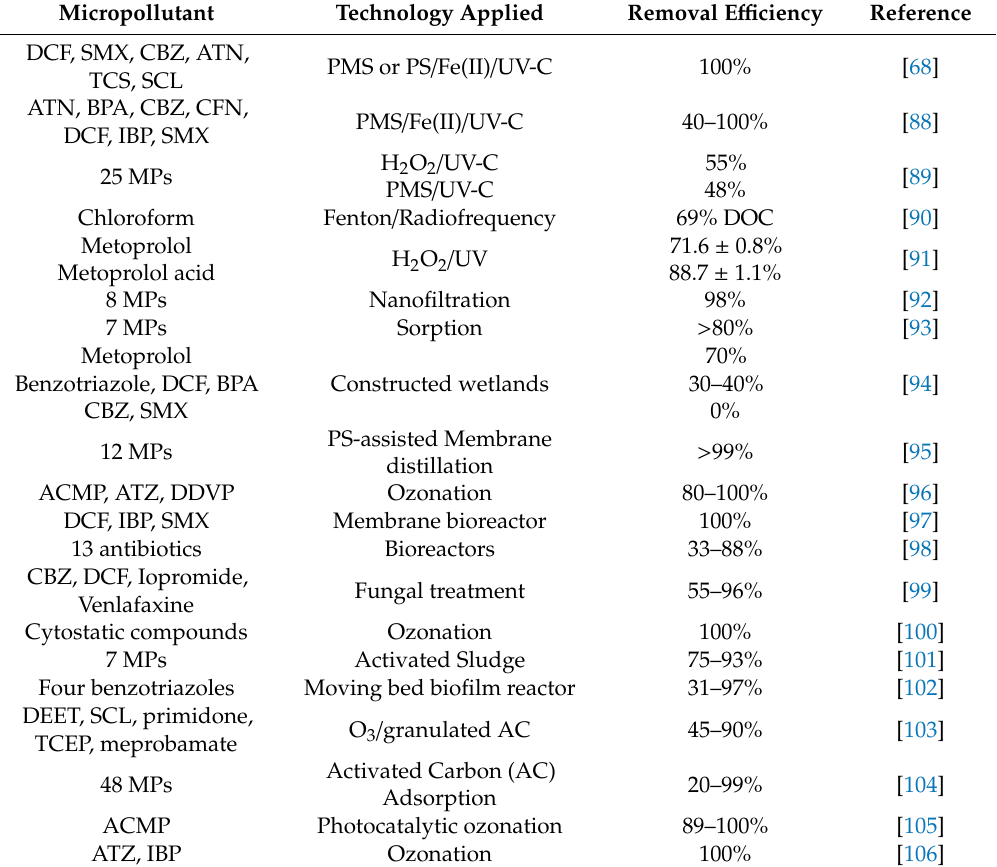
Table 3. Recent studies on the detection and / or removal of organic micropollutants in treated e ffl uents.